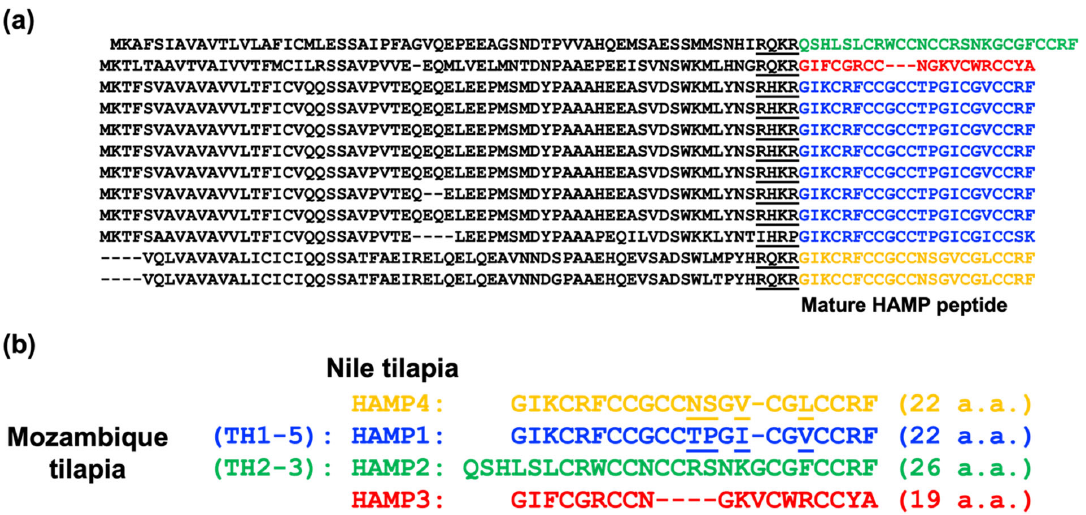
Figure 3. Twelve Nile tilapia hamp genes in LG11 encode four HAMPs: ( a ) the mature HAMP pep ‐ tide sequences in Nile tilapia. ( b ) Comparison of the HAMP mature peptides of Mozambique tilapia and Nile tilapia. The HAMP mature peptides Th1 ‐ 5 and Th2 ‐ 3 of Mozambique tilapia are identical to HAMP1 and HAMP2 of Nile tilapia, respectively. Moreover, HAMP3 and HAMP4 are only found in Nile tilapia.